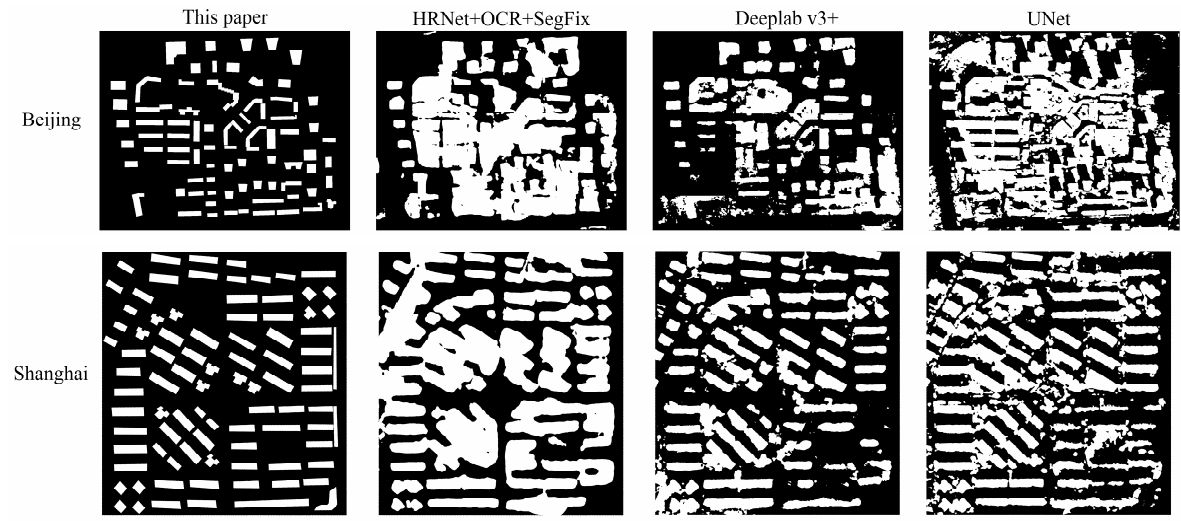
Figure 15. The comparison of results in this paper and different convolutional neural networks.